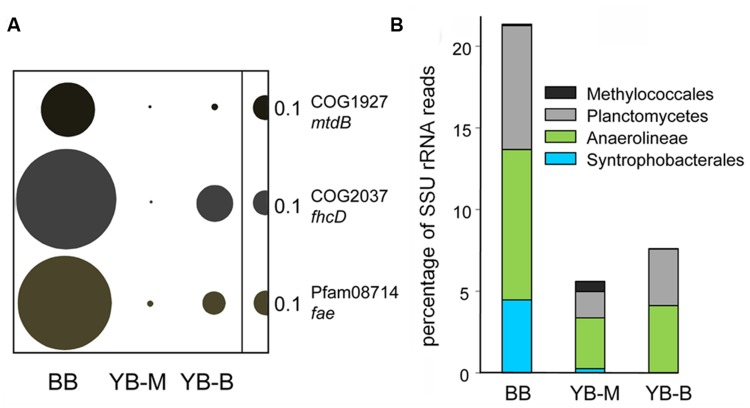
(A) Functional gene categories involved in methanotrophy/methylotrophy. The genes are mtdB, coenzyme F420-dependent N(5),N(10)-methenyltetra hydromethanopterin dehydrogenase; fhcD, formylmethanofuran:tetrahydromethanopterin formyltransferase; fae, formaldehyde-activating enzyme. Abundance of a functional gene category was calculated as the number of hits to a given category normalized by the effective bacterial genome equivalents in the corresponding assembled metagenome. Abundance values are indicated by bubble width, with the scale shown as a half-bubble to the right in each panel. (B) Relative phylogenetic abundance of putative methylotrophs and synthrophic bacteria are shown as the percentages of all SSU rRNA reads (selected by HMMER3 from unassembled metagenomes). Metagenome names are shown at the bottom, they indicate the sampling locations: BB, Baker Bay; YB-M, Youngs Bay mouth; and YB-B, Youngs Bay back.